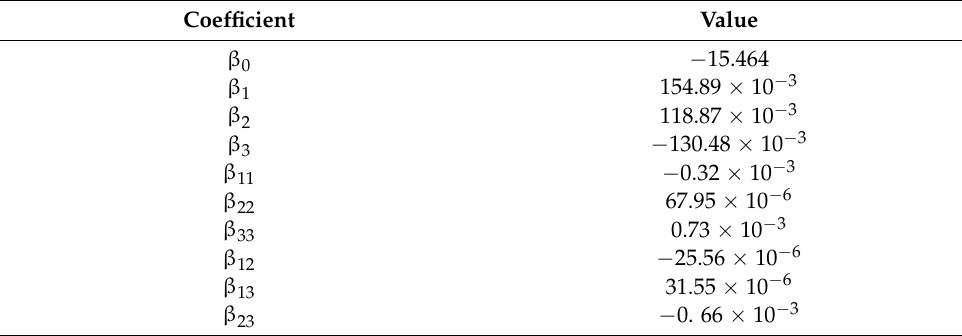
Table 10. Regression coefficients for maximum